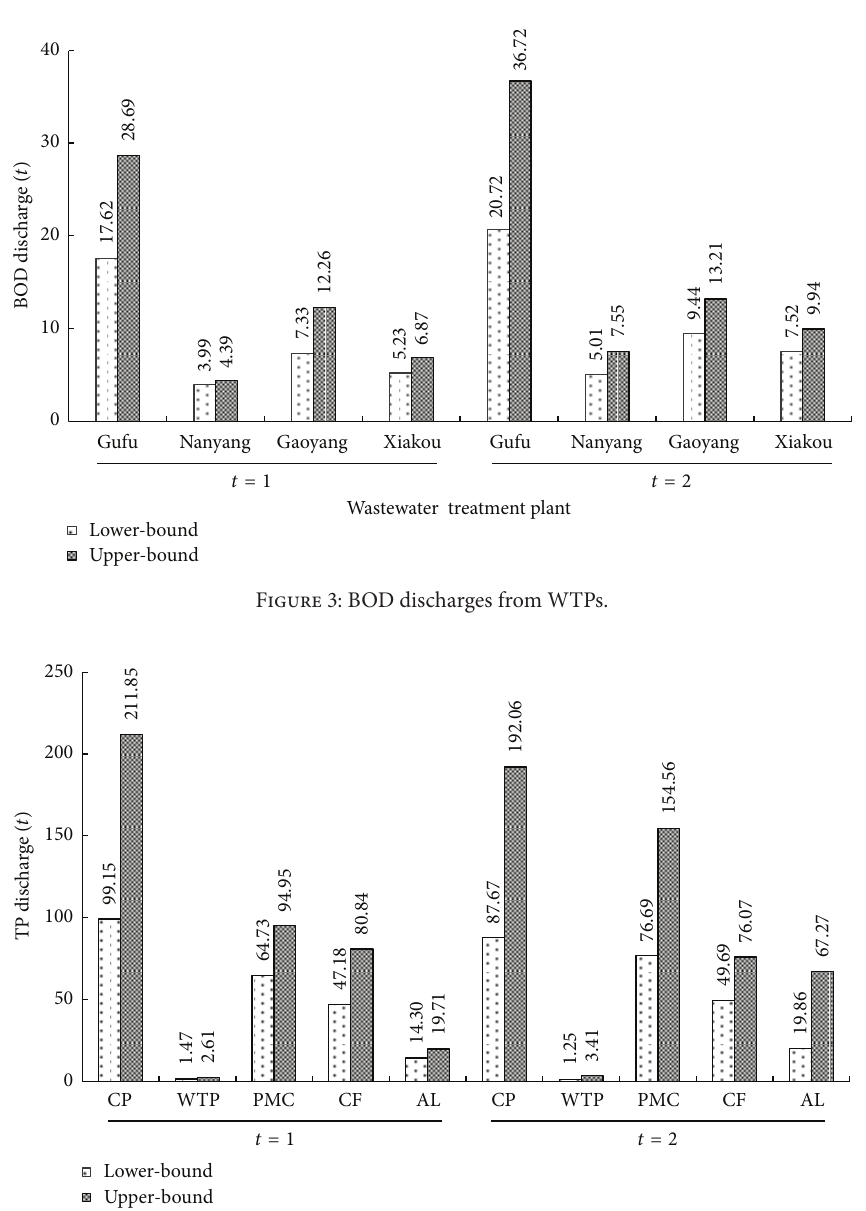
Figure 4: Solutions of TP discharge. Note: CP: chemical plant; WTP: wastewater treatment plant; PMC: phosphorus mining company; CF: crop farming; AL: agricultural